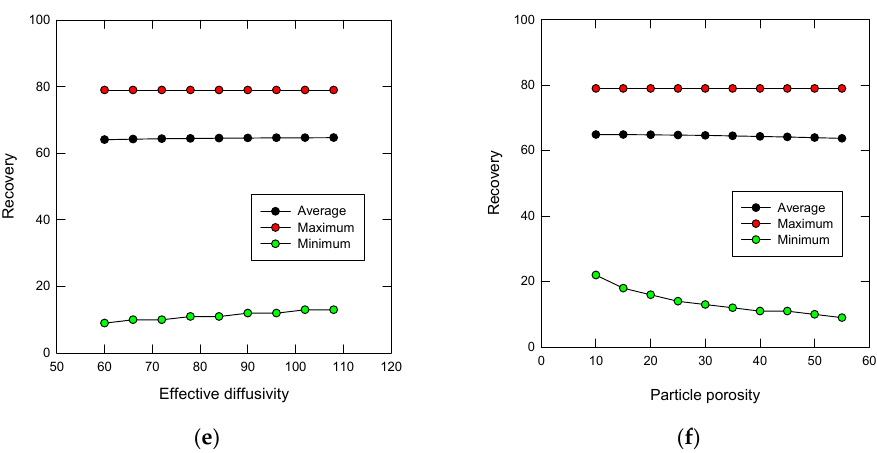
Figure 7. Copper recovery based on leaching time ( a ), particle size ( b ), pile high ( c ), superficial velocity of lixiviant flow ( d ), effective diffusivity of the solute within particle pores ( e ) and porosity of particle ( f ).